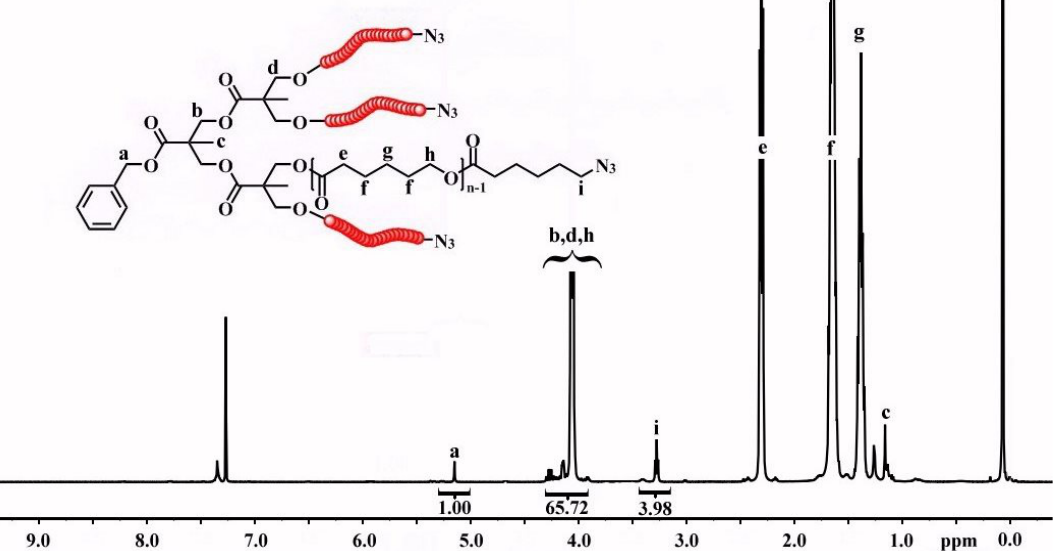
Figure 2. 1 H-NMR spectrum of the (PCL-azide)